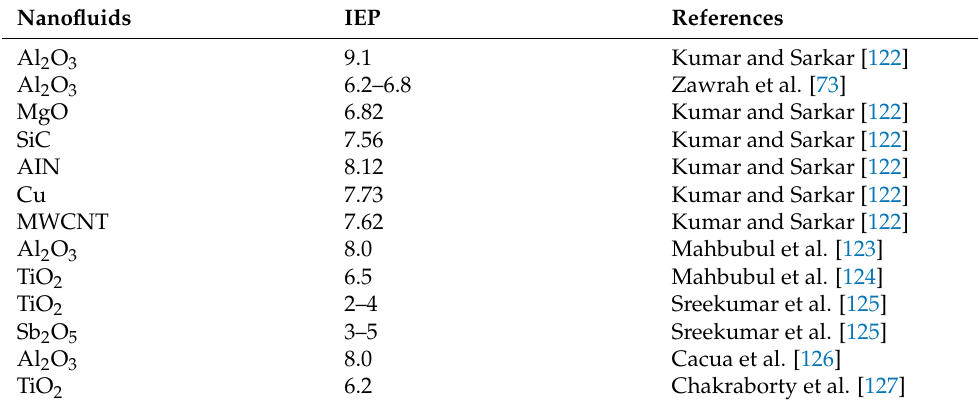
Table 2. Isoelectric points of mono and hybrid